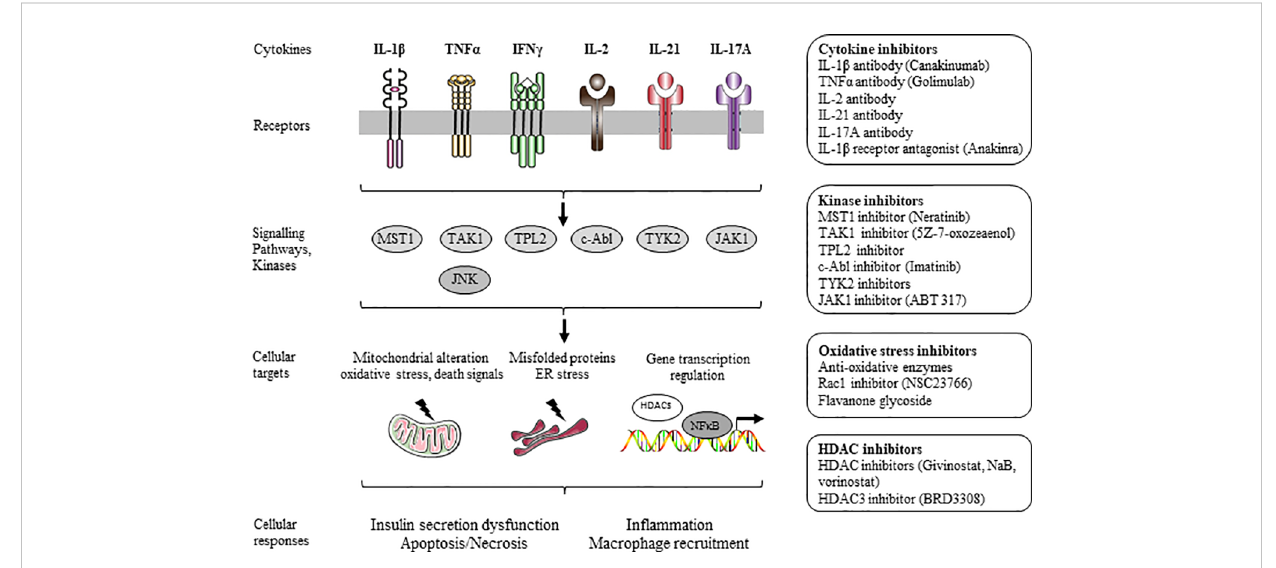
FIGURE 1 Inhibitors of b -cell dysfunction and death induced by in fl